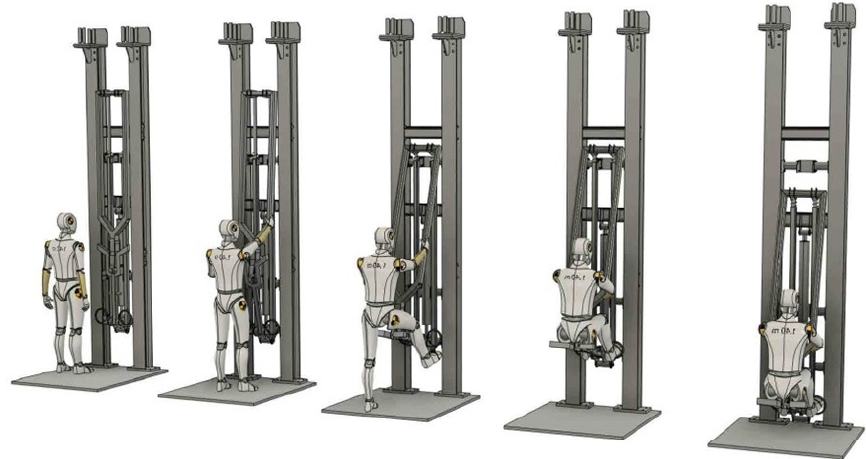
Figure 9. Chair solution and its fitness for child anatomy (1.40 m tall).